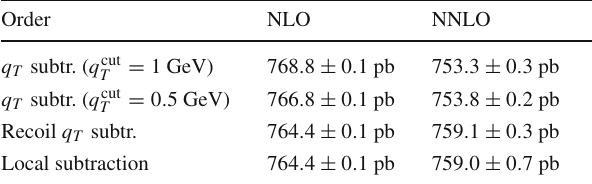
Table 1 Fiducial cross sections at the LHC ( order results at NLO and NNLO. The uncertainties on the values of the cross sections refer to the statistical uncertainties from Monte Carlo numerical integration